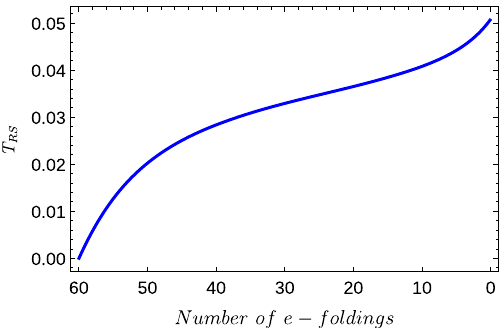
Fig. 3 The transfer function T RS as a function of number of e-foldings